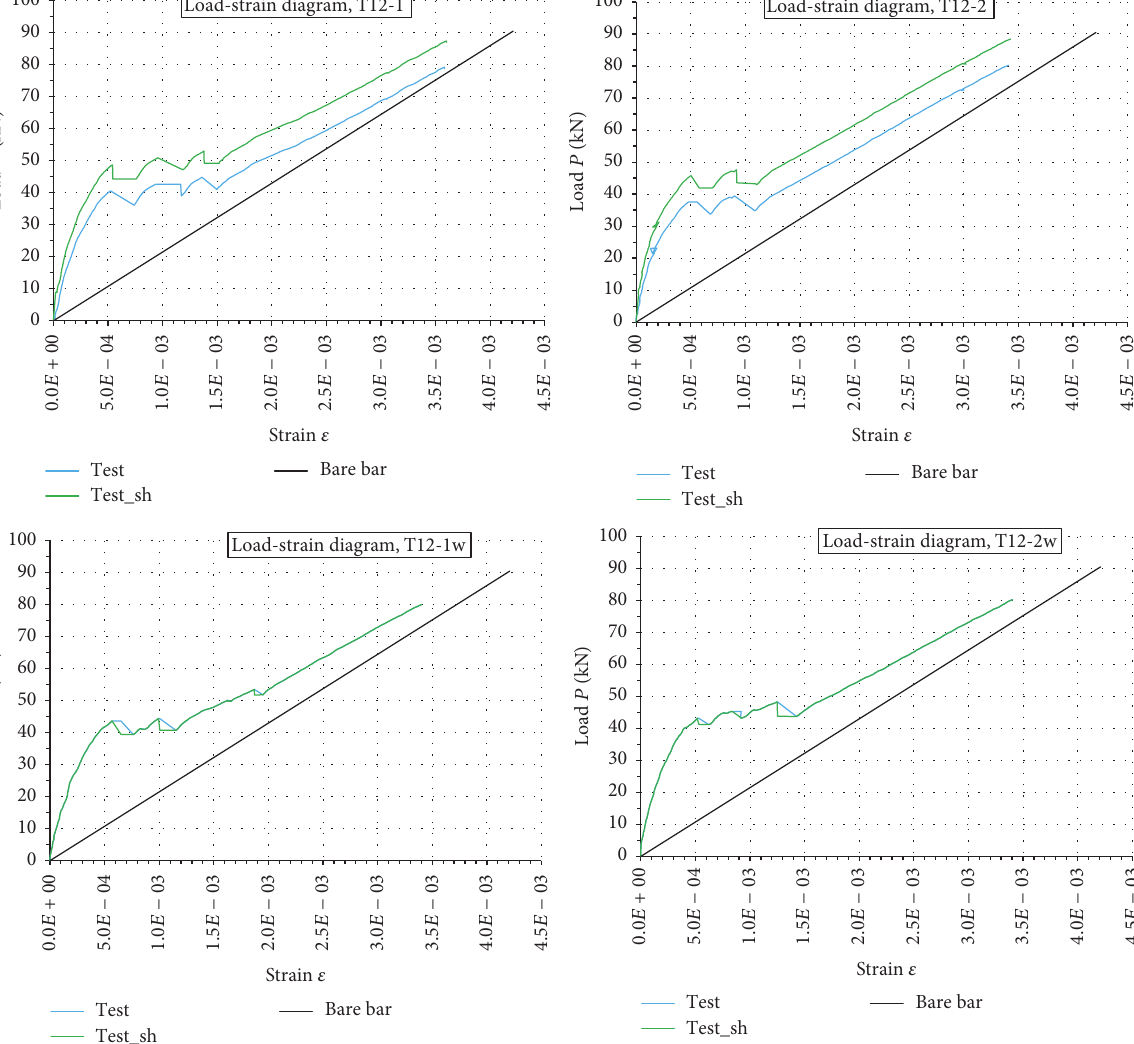
Figure 5: Free-of-shrinkage